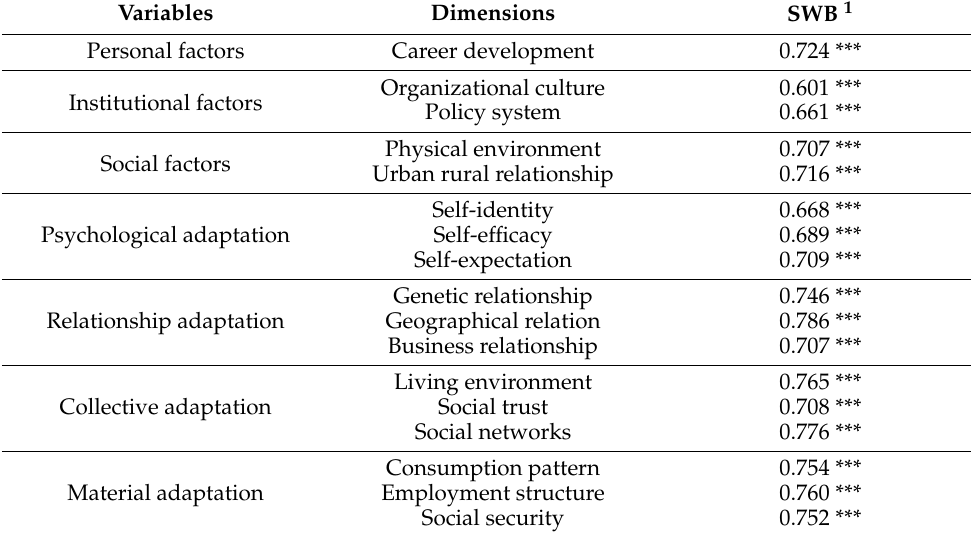
Table 4. The correlations between the core variables and happiness.